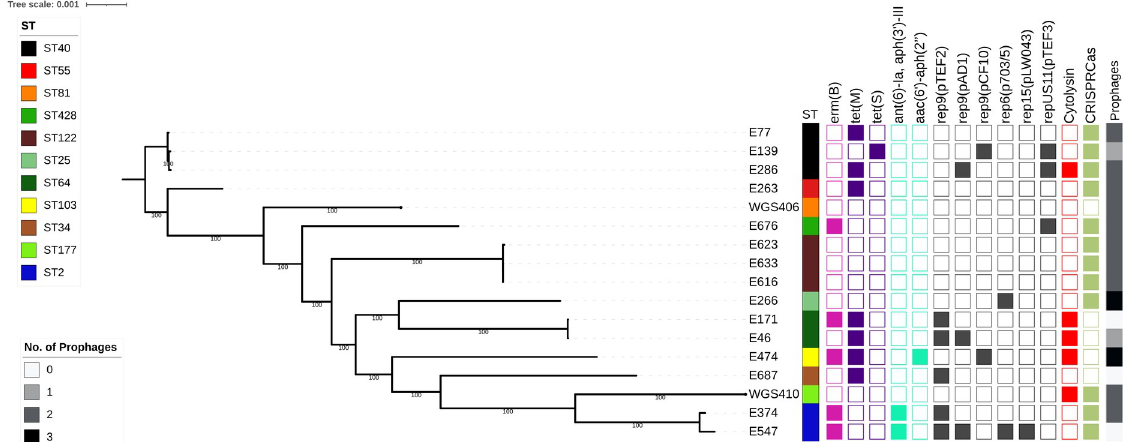
Fig 1. Core genome phylogeny of E . faecalis endophthalmitis isolates. Single-copy core genome phylogeny of 15 UPMC Campbell Lab isolates plus two additional genomes from NCBI (WGS406 and WGS410), all isolated from endophthalmitis. The RAxML tree is built from single nucleotide polymorphisms (SNPs) in 2024 single copy core genes identified with Roary. Tips are annotated with isolate name, multi- locus sequence type (ST), drug resistance-associated genes, plasmid rep genes, cytolysin operon presence, CRISPR-cas loci presence, and prophage abundance in each genome. CRISR-cas-positive isolates had Class 1 and/or Class 2 Cas proteins associated with their CRISPR loci. Intact or questionable prophages were identified with PHASTER. erm(B) = erythromycin resistance, tet(M) and tet(S) = tetracycline resistance, ant(6)-Ia , aph(3 0 )-III and aac(6’)-aph(2 @ ) = aminoglycoside resistance.